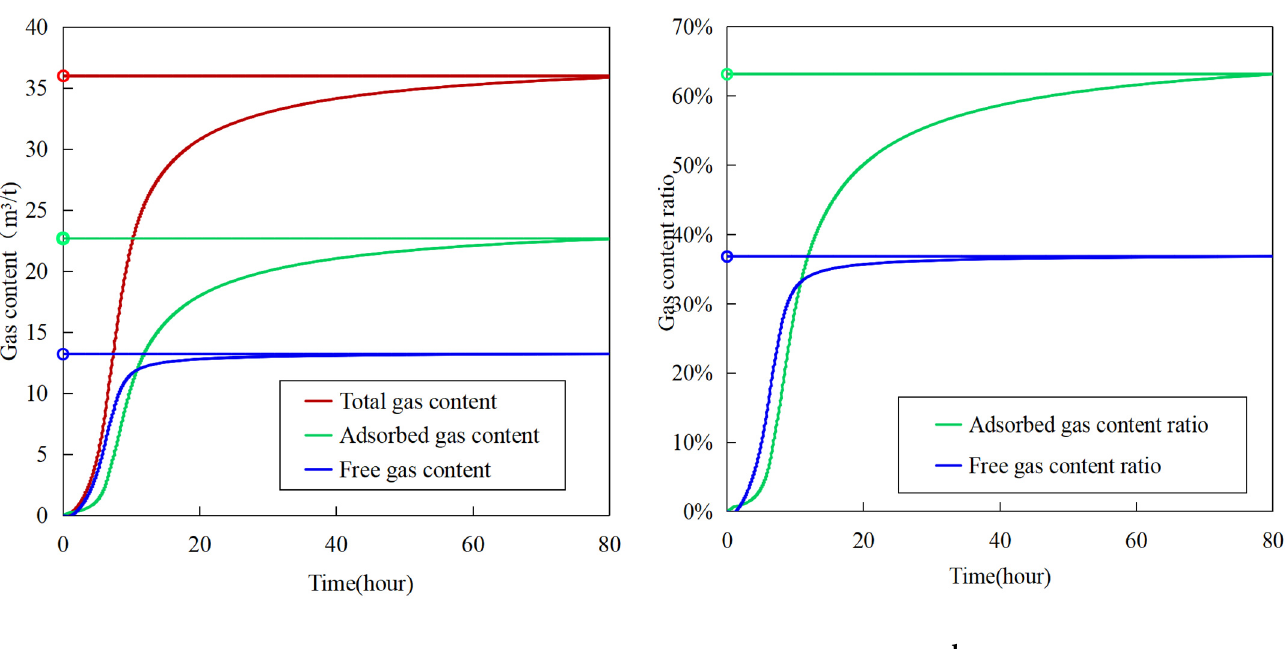
Figure 7. Changes in the Adsorbed Gas-to-Free Gas Ratio during the Loss Process. (( a ): Release amount of adsorbed gas and free gas; ( b ) Release amount ratio of adsorbed gas and free gas.)